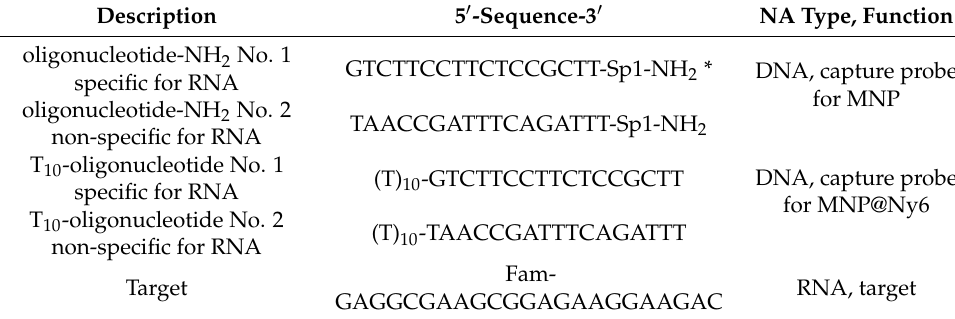
Table 2. Oligonucleotide sequences for RNA microextraction experiments.